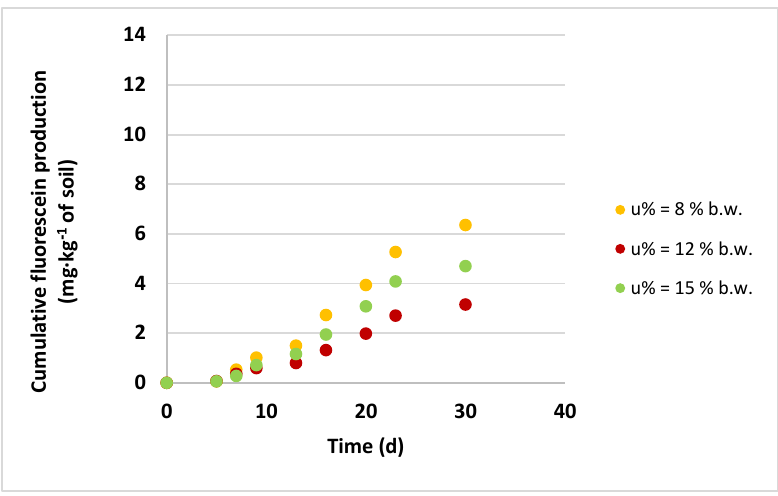
Figure 3. Cumulative fluorescein production by microcosms with C/N = 180.